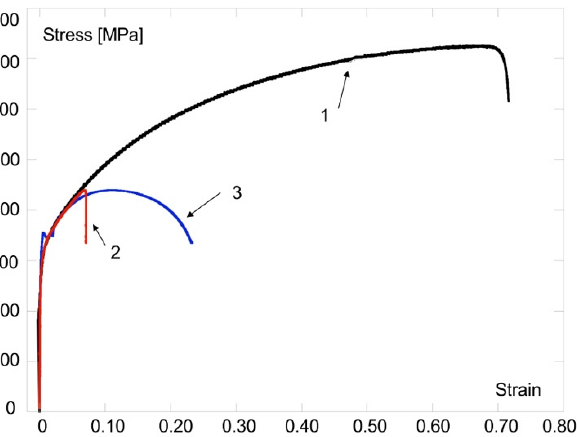
Figure 9. Engineering stress–strain curves of: 1, full SS flat specimen (clip-on extensometer data); 2, SS region of the LW joint (E3 virtual extensometer data); 3, CS–SS joint (E1 virtual extensometer data).